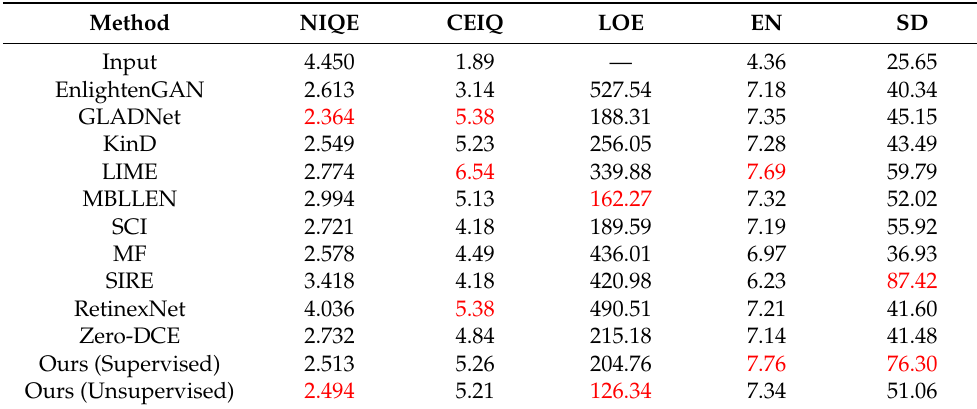
Table 1. Different Image Metrics in Low-Light